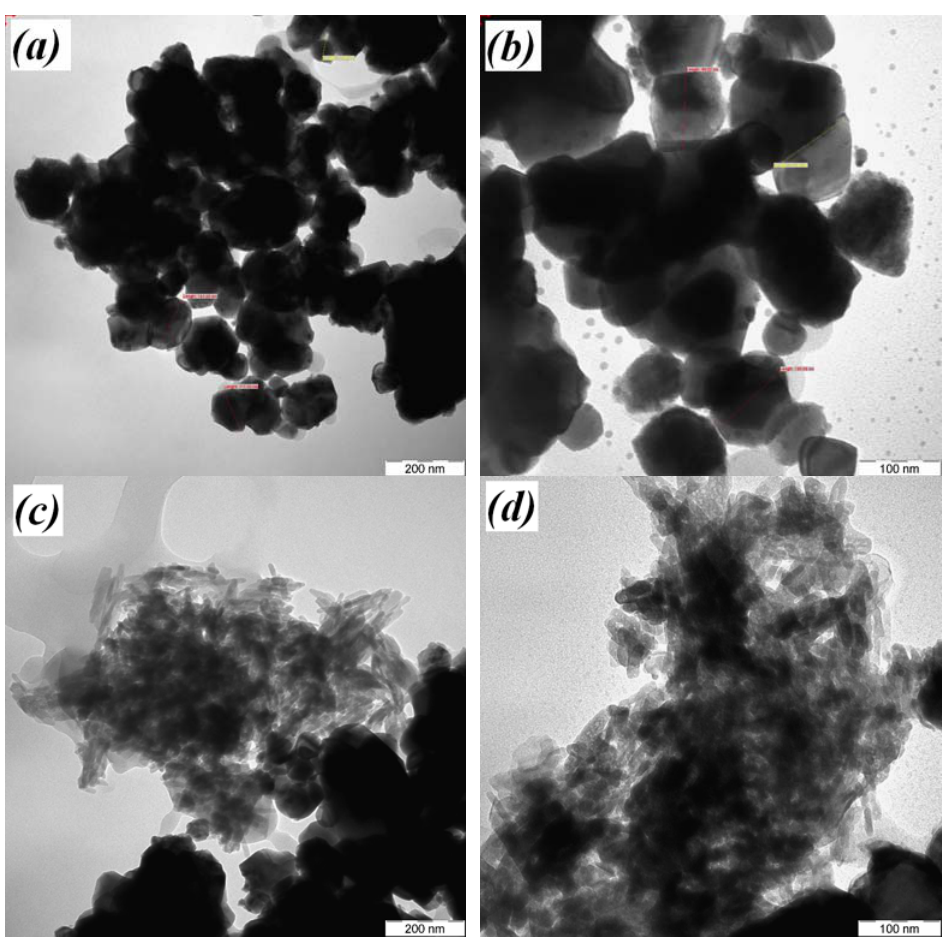
Figure 5. TEM micrographs of x WO (d) x =